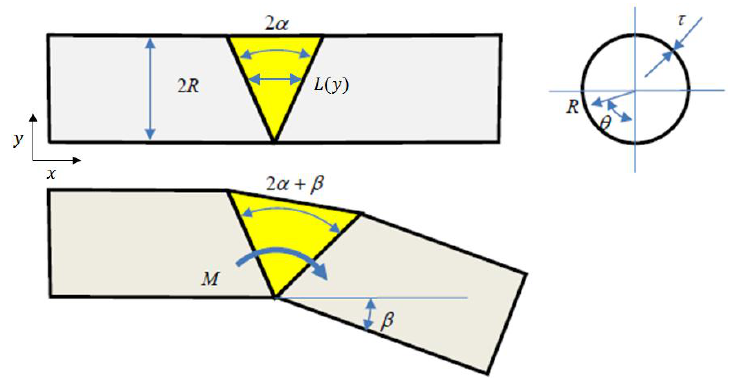
Figure 1. Schematic representation of the HELM hinge and relevant parameters.